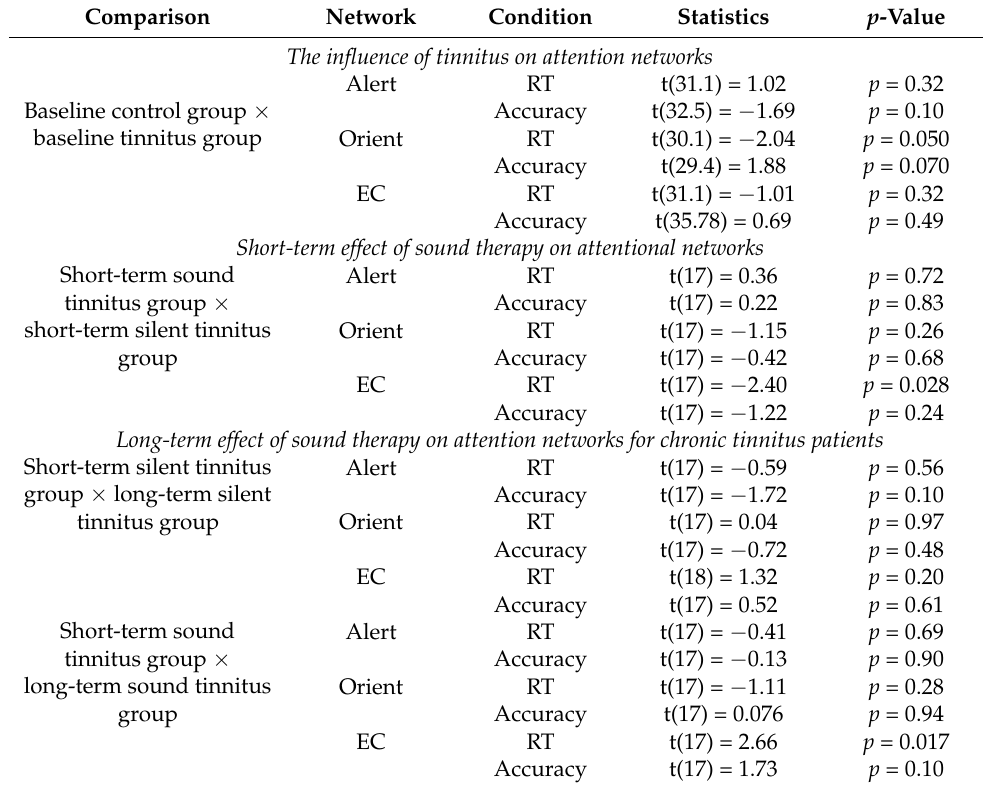
Table 2. Overview of the statistical comparisons for the alerting (Alert), orienting (Orient) and executive control (EC)